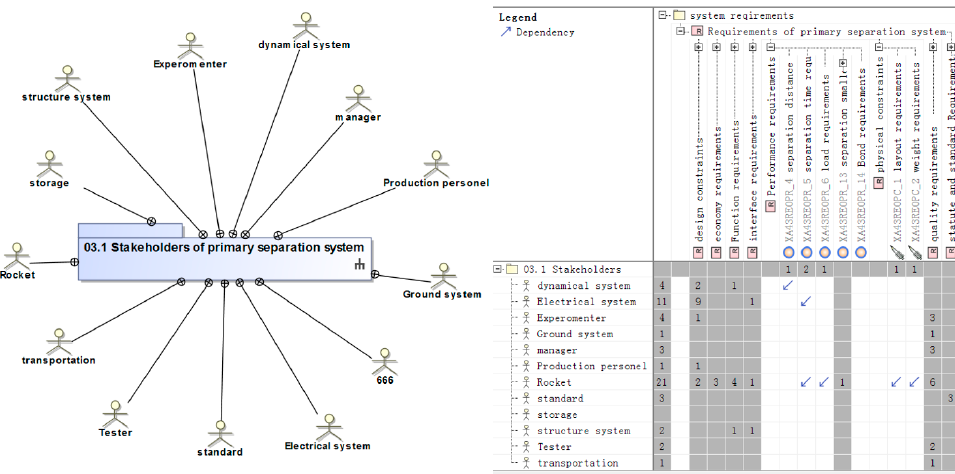
Figure 2. Who proposes requirements.